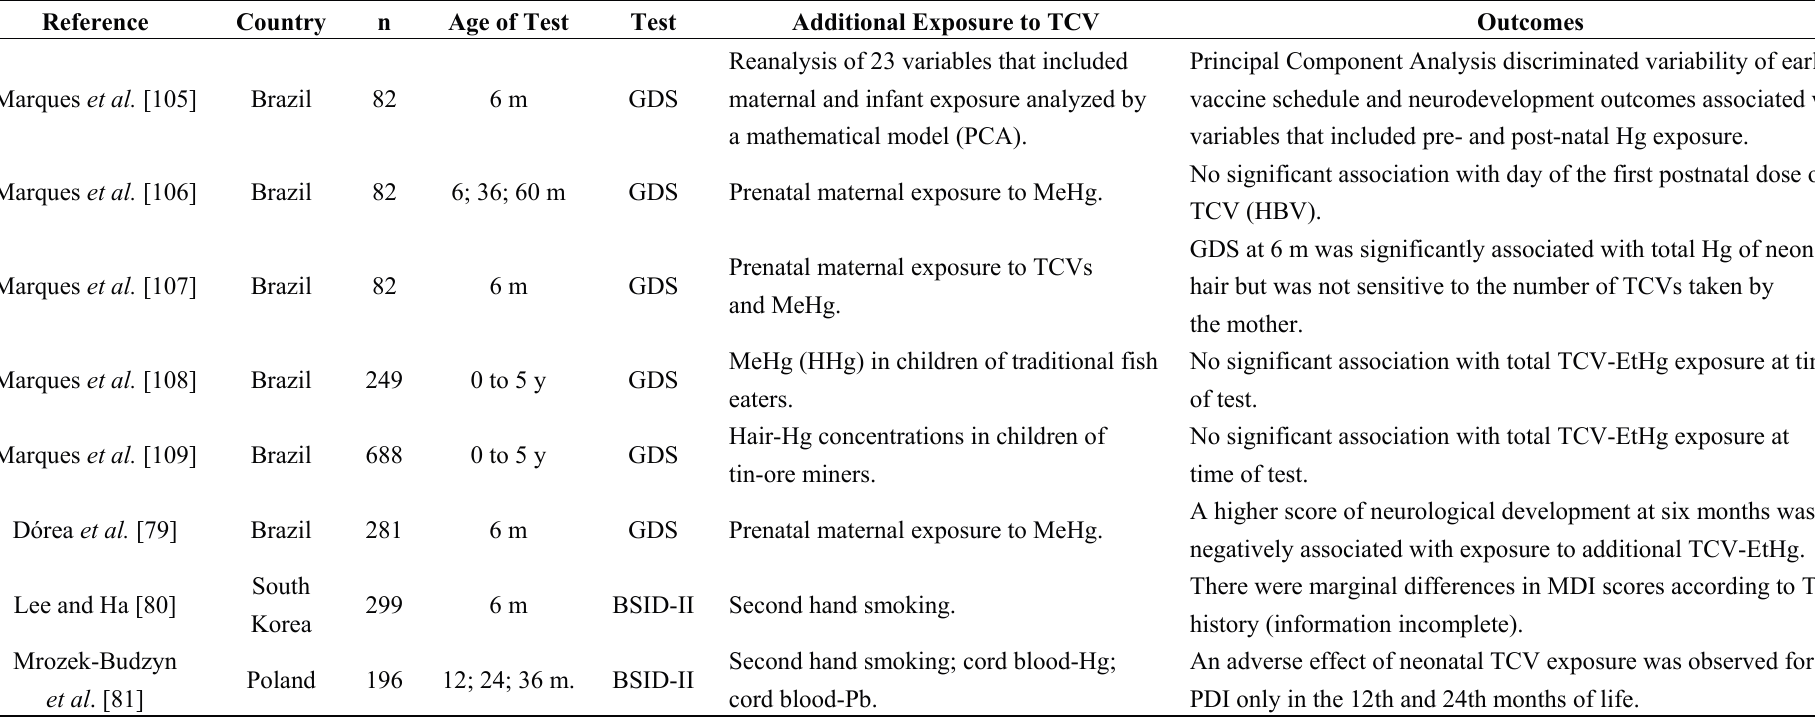
Table 1. Chronologically organized summary of studies addressing multiple exposures that include Thimerosal-containing vaccines (TCVs) given to infants and neurodevelopment outcomes, by country, age, neurological test used, and the co-occurring